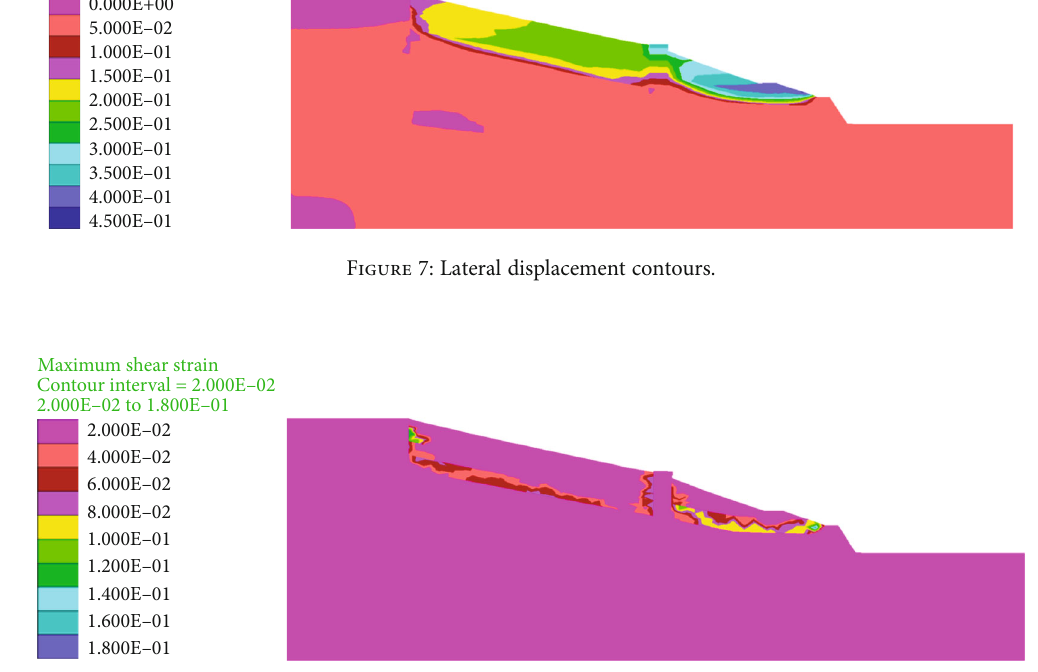
Figure 8: Shear strain